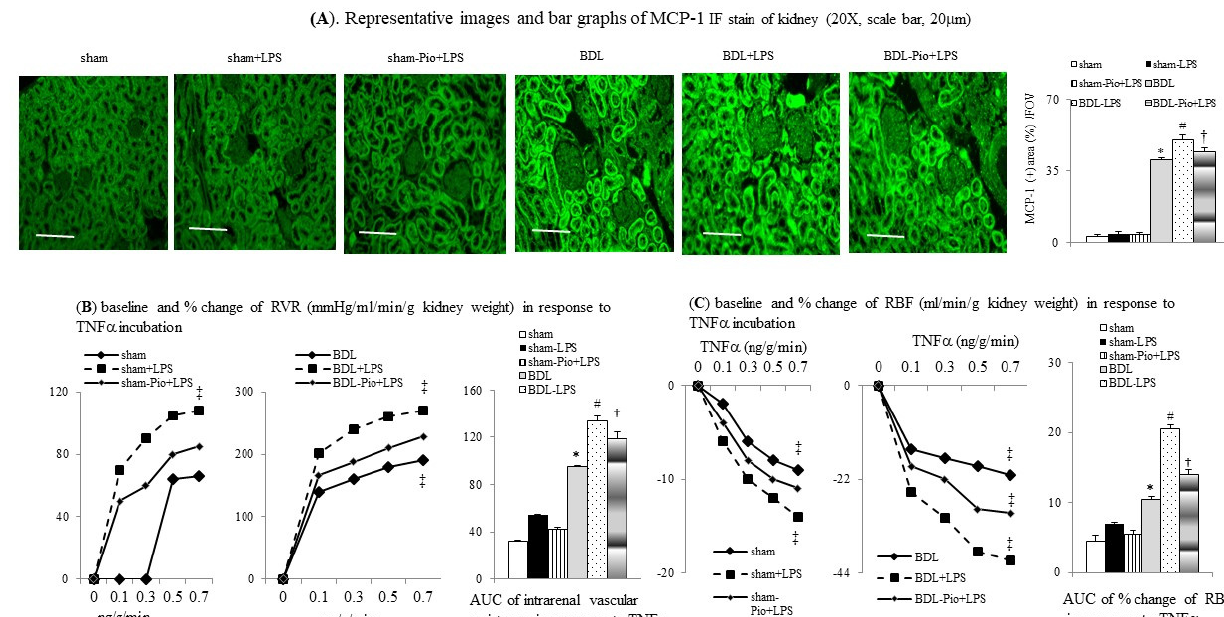
Figure 4. Chronic pioglitazone treatment inhibited the lipopolysaccharide (LPS)-enhanced TNF α and tumor necrosis factor α (TNF α )-induced increase in renal vascular resistance (RVR) of BDL-cirrhotic rats. ( A ) Immunofluorescence (IF) stain of monocyte chemoattractant protein-1 (MCP-1) expression in rat kidney. Concentration-response curve and bar graphs of AUC of ( B ) RVR and ( C ) renal blood flow (RABF) in response to cumulative concentrations of TNF α ; * p < 0.05 vs. sham group; # p < 0.05 vs. BDL group; † p < 0.05 vs. BDL-LPS; ‡ p < 0.05 vs. lower concentration of TNF α .